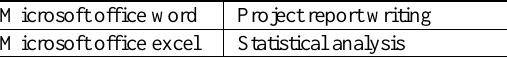
Table 3. Software and tools for processing and analysis.